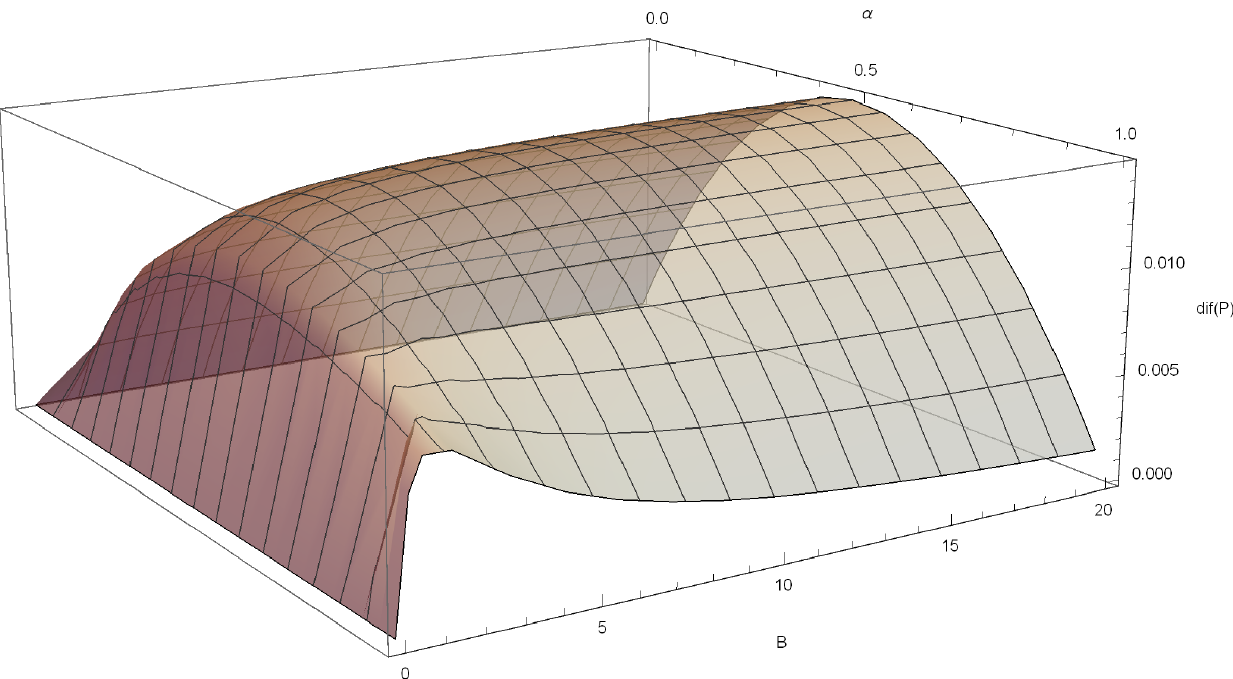
Fig 3. dif ( F ) in the Poisson-Pareto case with δ = 0.03, λ = 1, θ = 3.